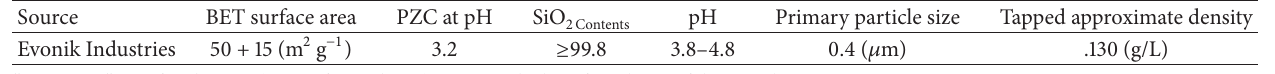
Table 1: Physicochemical properties of AEROSIL OX 50, as per the manufacturer information.